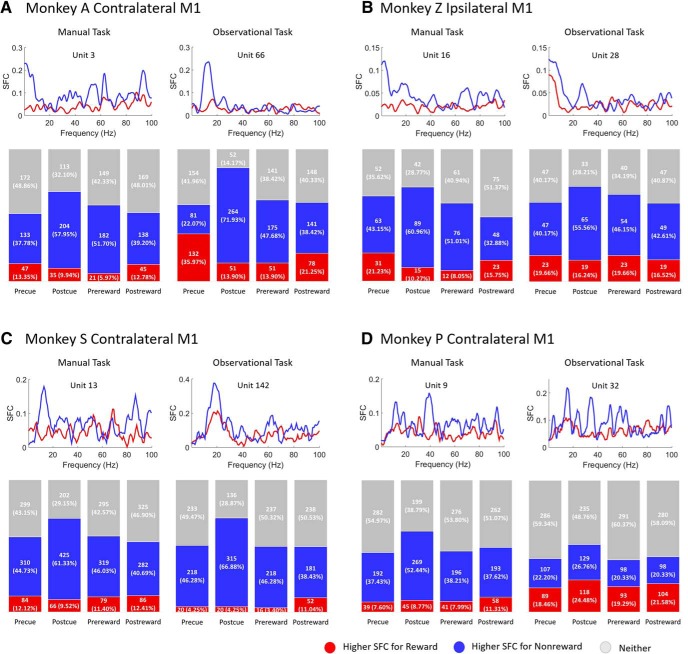
SFC plots (upper row in each subplot) for sample units for rewarding (red) and nonrewarding (blue) trials across manual (left column in each subplot) and observational (right column in each subplot) tasks for contralateral (A, C, D) and ipsilateral (B) M1 cortices. Bar charts (lower row in each subplot) represent the population of significantly different M1 units for SFC values in α-band (8–14 Hz) during rewarding (red) and nonrewarding (blue) trials, and those with no significant difference (gray; Wilcoxon signed-rank test, p < 0.05). Each column in the bar chart represents precue (before cue, 500 ms), postcue (after cue, 800 ms), prereward (before reward, 500 ms), and postreward (after reward, 500 ms) periods. A, B are for the center-out reaching tasks, and C, D are for the grip force tasks.